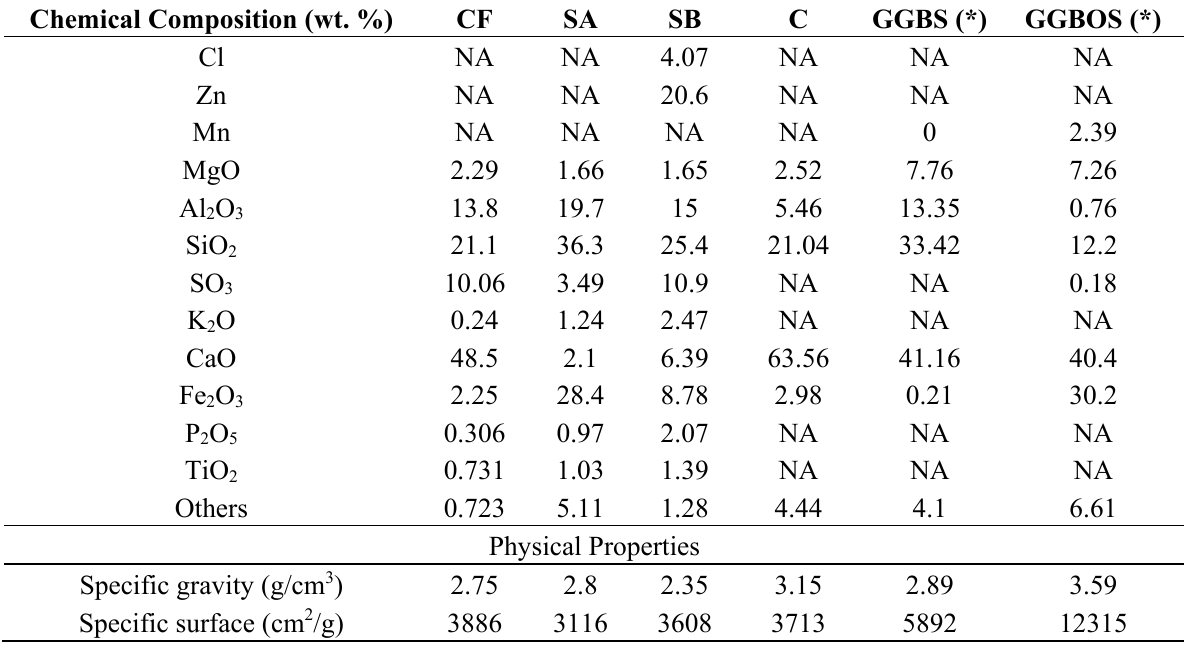
Table 2. Chemical composition and physical analysis of test specimens. Chemical Composition (wt.